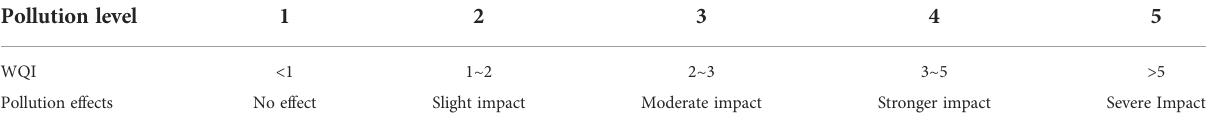
TABLE 1 Classi fi cation standard for the pollution level of heavy metals in seawater.